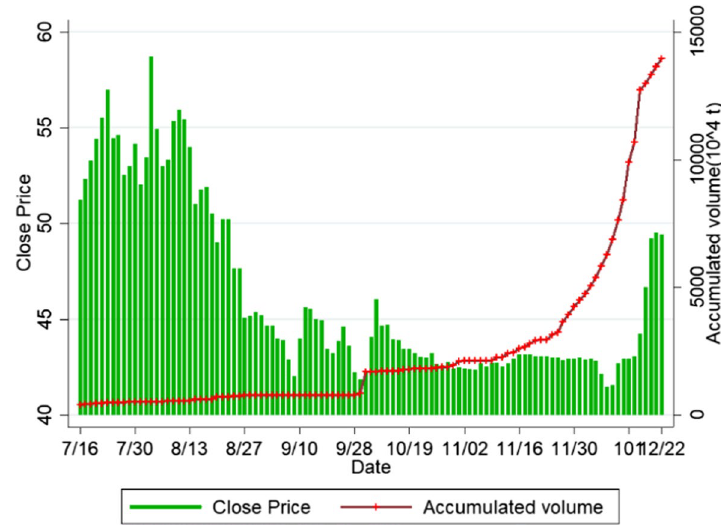
Fig. 2 The transaction situation of China’s national